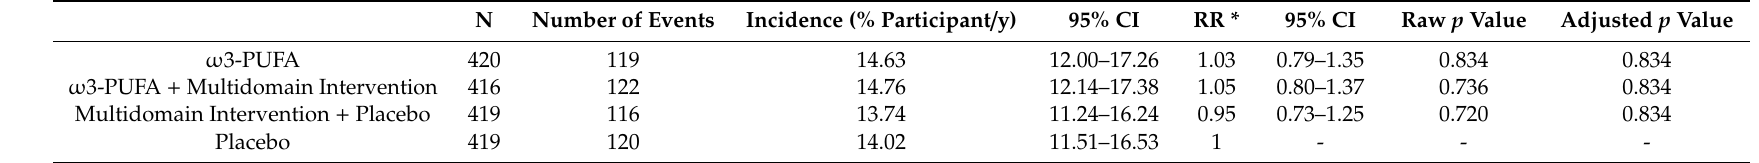
Table 4. Estimated risk of 3-year balance performance decline (95%